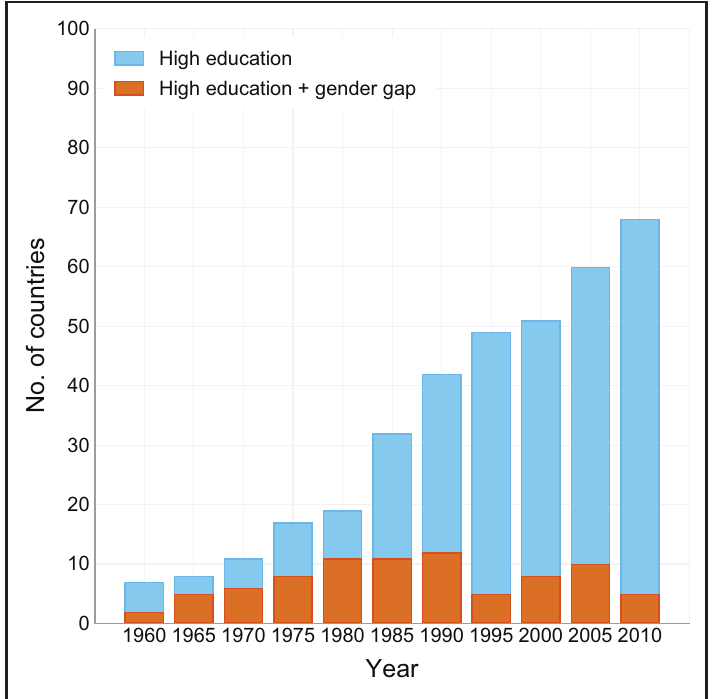
Figure 5 The Number of High-Education Countries by